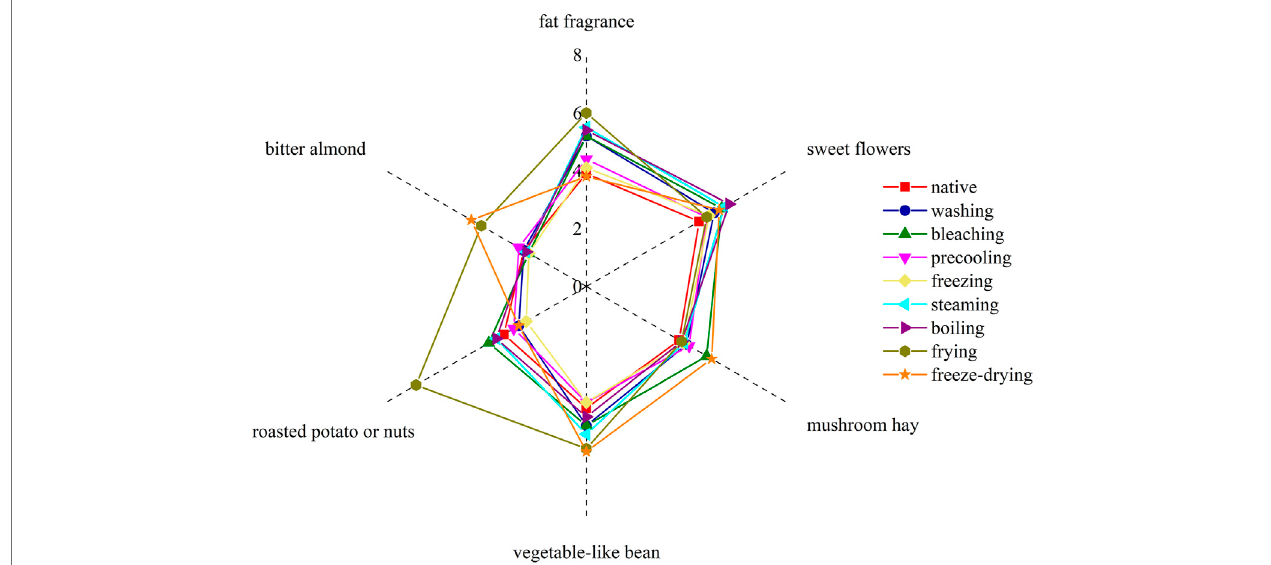
FIGURE 4 | Aroma pro fi le of corn under nine kinds of different treatments.